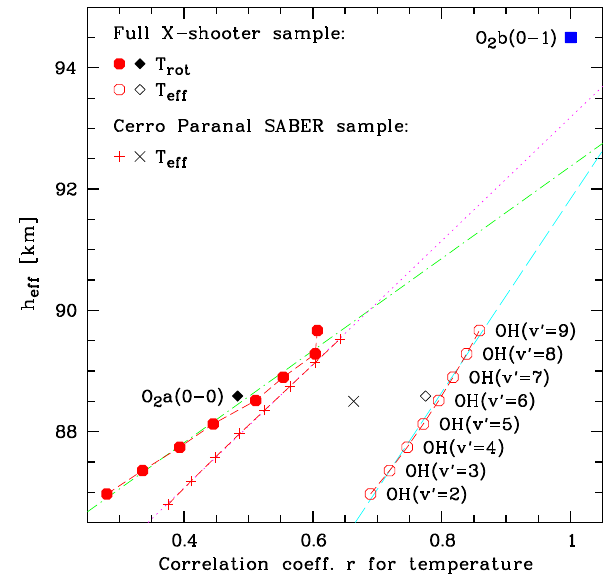
Figure 11. Effective emission height h eff in km from SABER data vs. the correlation coefficient r for the correlation of the T rot (filled symbols), T eff for the full X-shooter sample (open symbols), and T eff for the Cerro Paranal SABER sample (crosses) of OH( v (cid:48) ) and O 2 a (0-0) with those of O 2 b (0-1). The dash-dotted ( T rot , X- shooter sample), long-dashed ( T eff , X-shooter sample), and dotted line ( T eff , SABER sample) show fits of the OH data, which are con- nected by short dashed